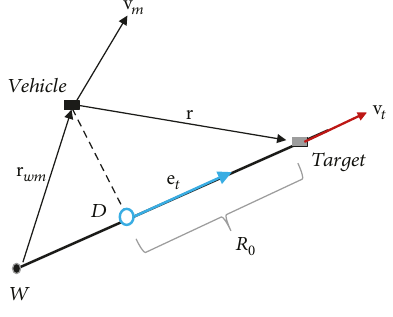
Figure 6: Straight-line path following.